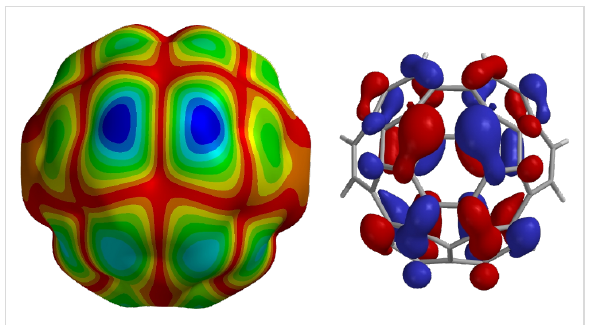
Figure 6: LUMO orbital map of circumtrindene (B3LYP/6-31G*). The darkest blue areas correspond to the regions with the largest LUMO coefficients.